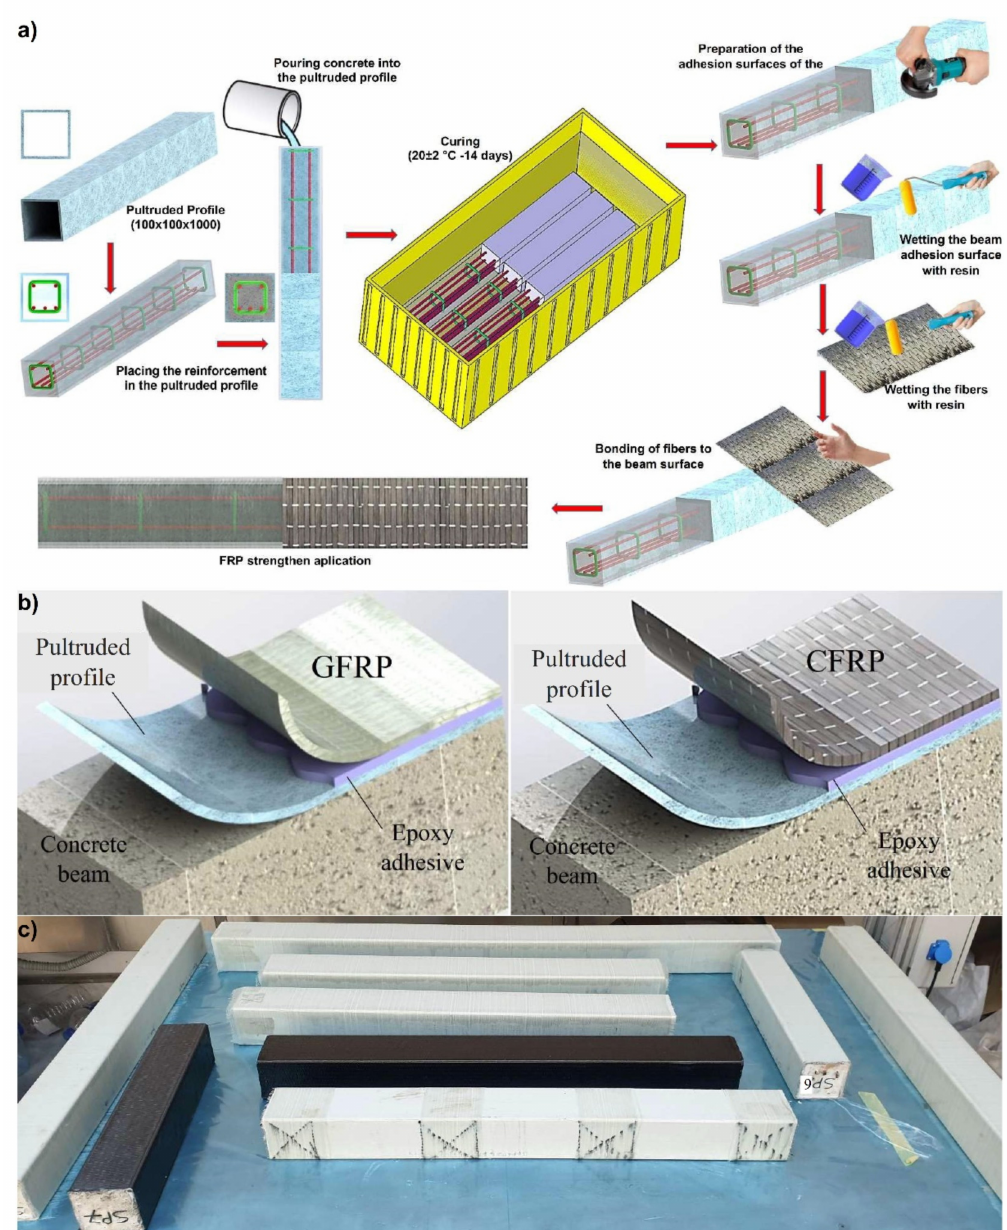
Figure 3. Hybrid beams production stages ( a ) schematic representation of the production process ( b ) application method of uniaxial GFRP and CFRP fabrics ( c ) The appearance of FRP applied samples during